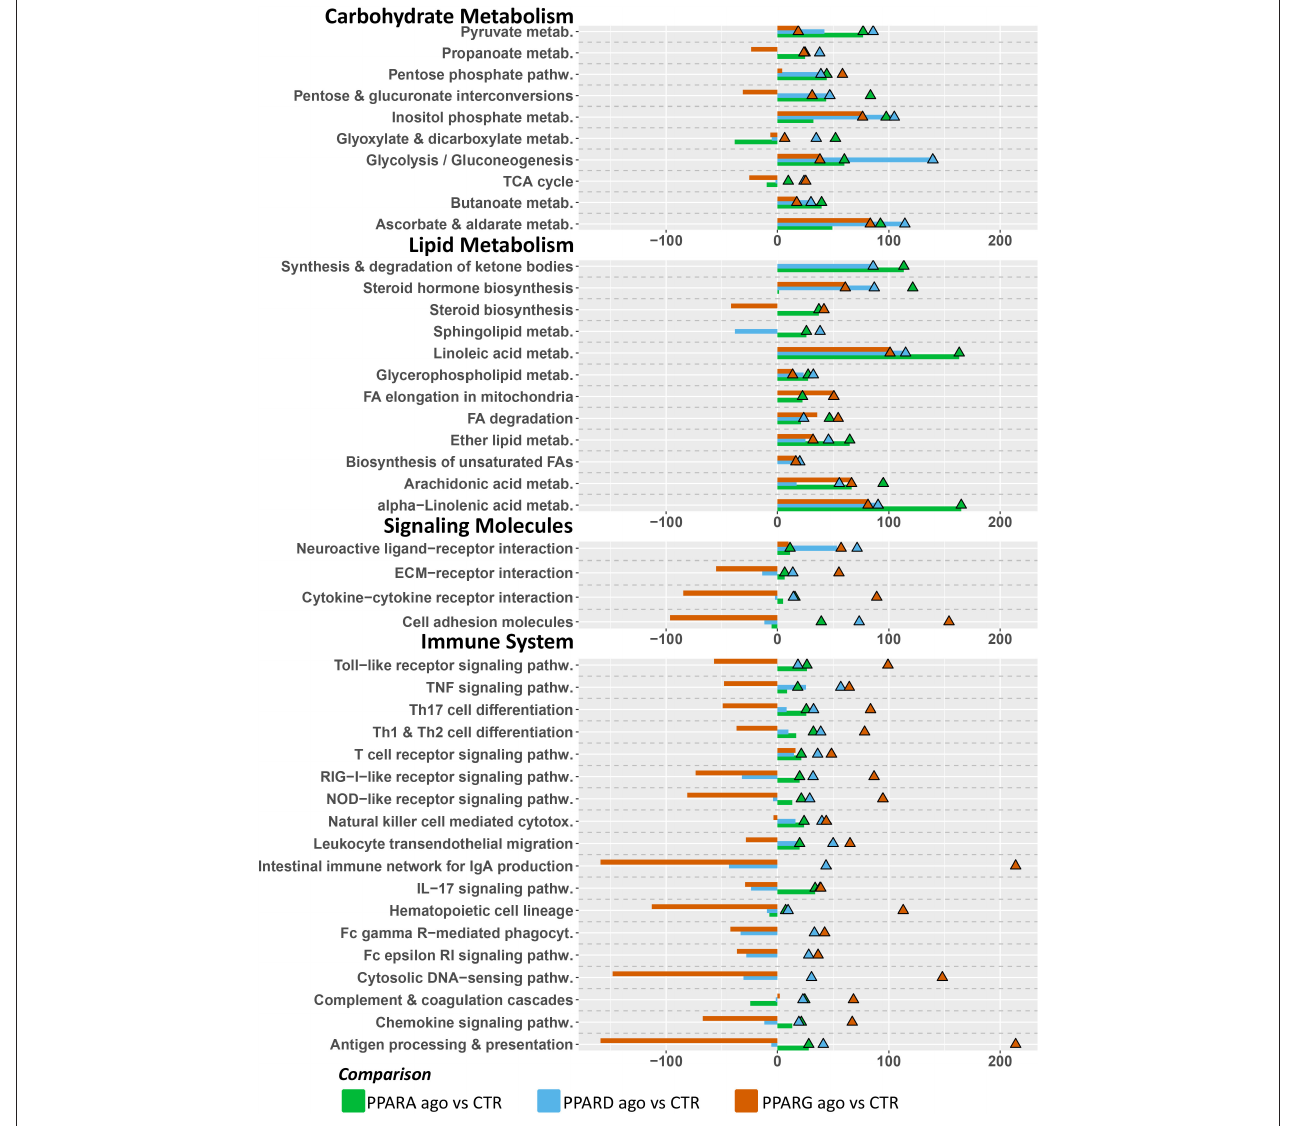
FIGURE 5 | Main KEGG pathways highlighted by DIA, divided by subcategory. Triangles (color-coded) represent the impact in terms of overrepresented genes in the pathways, whereas bars (also color-coded) refer to the overall flux of the pathway, with negative numbers indicating inhibition of the pathway, and positive numbers indicating induction of the